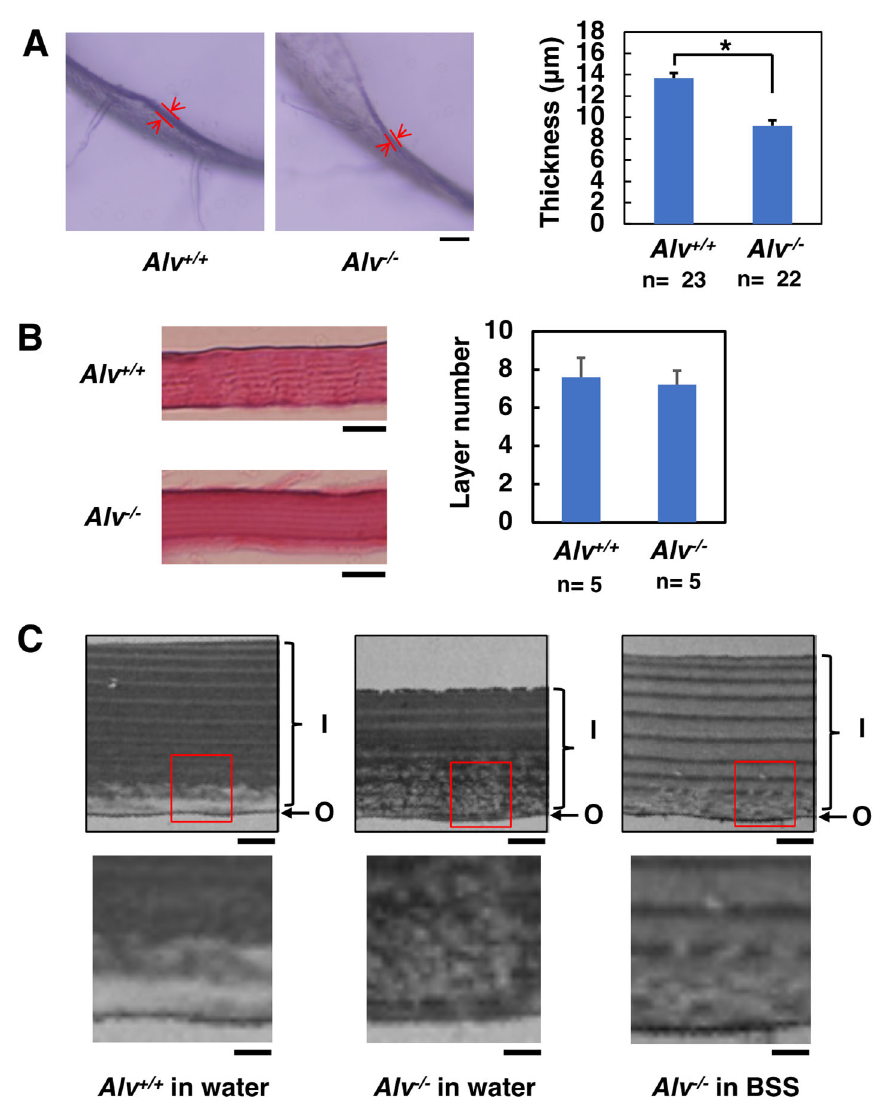
Figure 6. Morphological observation of the chorions. ( A ) Light microscopic images (left) and the thickness (right). Light microscopic images of the chorion. The scale bar, 50 mm. The chorion section indicated by the red arrows was measured as the thickness. The average thickness is shown and the error bars represent standard deviations. * p < 0.05; ( B ) Hematoxylin-eosin staining (left) and the layer number (right). Photos of the chorion from the Alv +/+ and Alv − / − fertilized eggs. The scale bars, 10 mm. The average number of the layers at five different parts of fertilization envelope are shown. The error bars represent standard deviations; ( C ) Transmission electron microscopic images. The upper panels show the photos of chorions derived from Alv +/+ eggs in water, Alv +/ − eggs in water, and Alv − / − eggs in BSS. I, the inner layer; O, the outer layer. The scale bar, 10 mm. The lower panels show magnified images of the red squares in the upper panels. The scale bar, 100